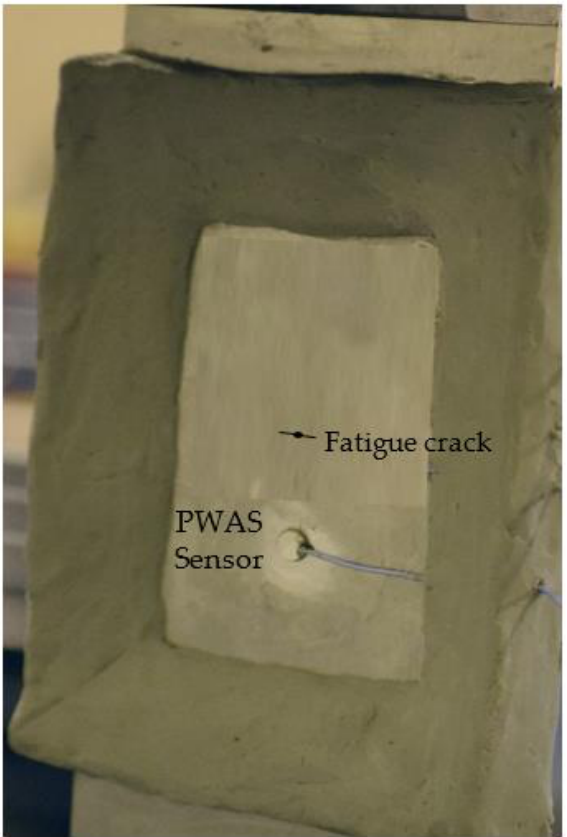
Figure 8. AE test specimen installed with the PWAS sensor. Non-reflective clay boundaries (NRBs) were provided on the specimen to avoid the reflection of AE signals from the specimen boundaries.